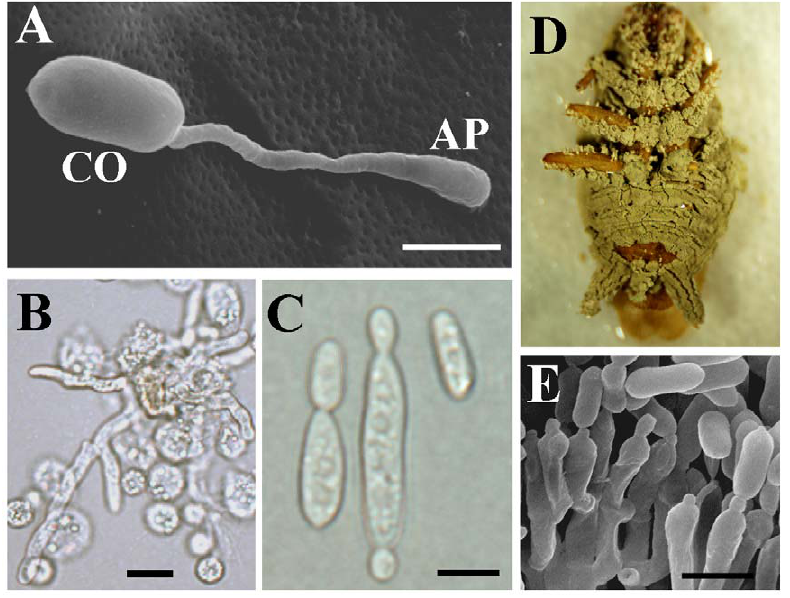
Figure 1. Major stages in the infection cycle of Metarhizium . (A) A germinating conidium producing an appressorium. (B) Mycelia attacked by hemocytes after cuticular penetration. (C) Budding yeast-type cells (blastospores) produced by the fungus to facilitate dispersal in insect hemocoel. (D) Cadaver showing emerging hyphae producing conidia (E). CO, conidium; AP, appressorium. Bar, 5 m m.